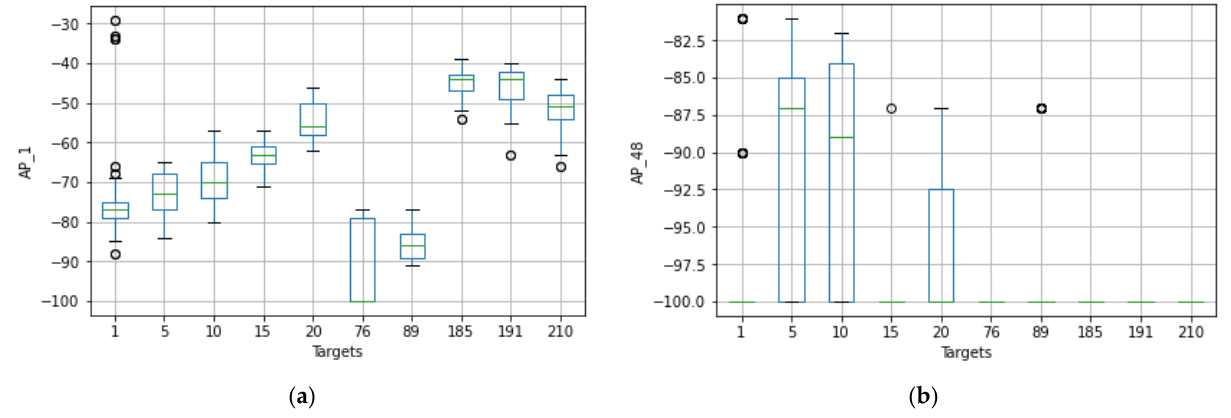
Figure 24. Distribution analysis of Wi-Fi RSS training measurements of different APs based on box and whisker plot. The small circles found above and below the whisker box plot represents the outliers of the training measurements received from the Wi-Fi APs of ( a ) AP_1 and ( b ) AP_48.